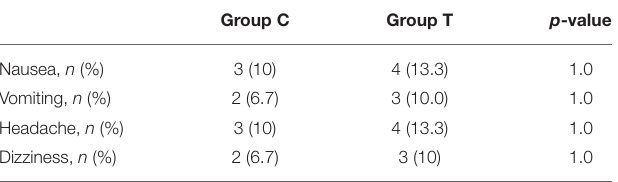
TABLE 4 | Postoperative complications * . Group C Group T